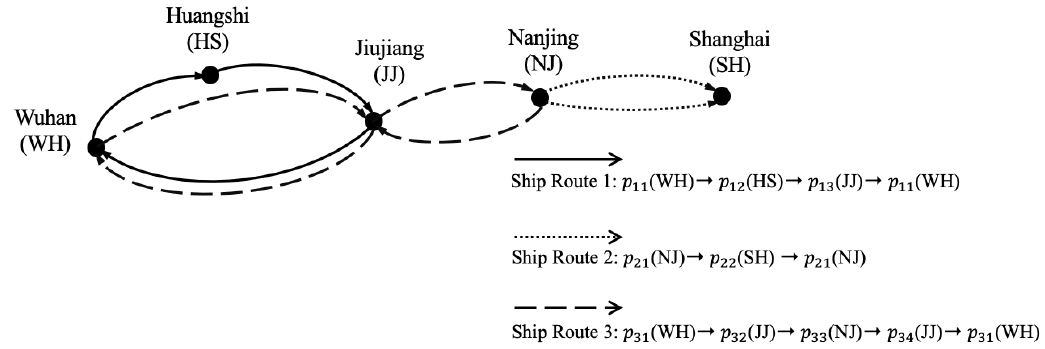
Figure 1. A liner shipping network with three ship routes.